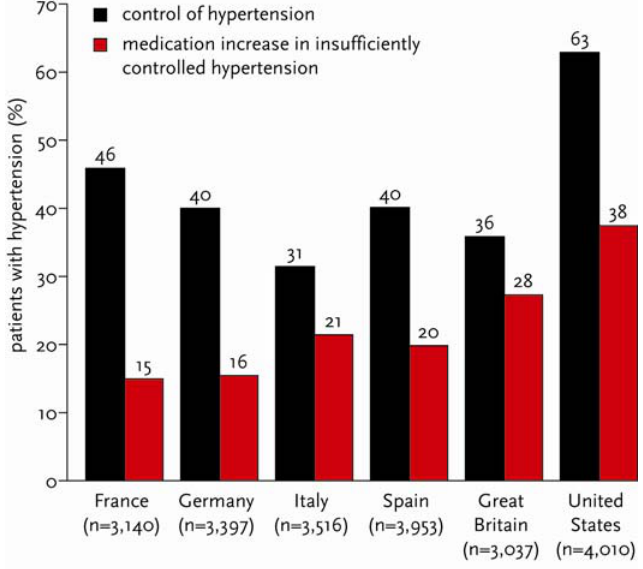
Figure 1. International differences in control of hypertension (systolic blood pressure <140 mmHg and diastolic blood pressure <90 mmHg) and medication increase in patients with insufficiently controlled hypertension [2] (confidence intervals were not given in the report but were small given the large samples, e.g., 44.2–47.7% and 13.8–16.2% for